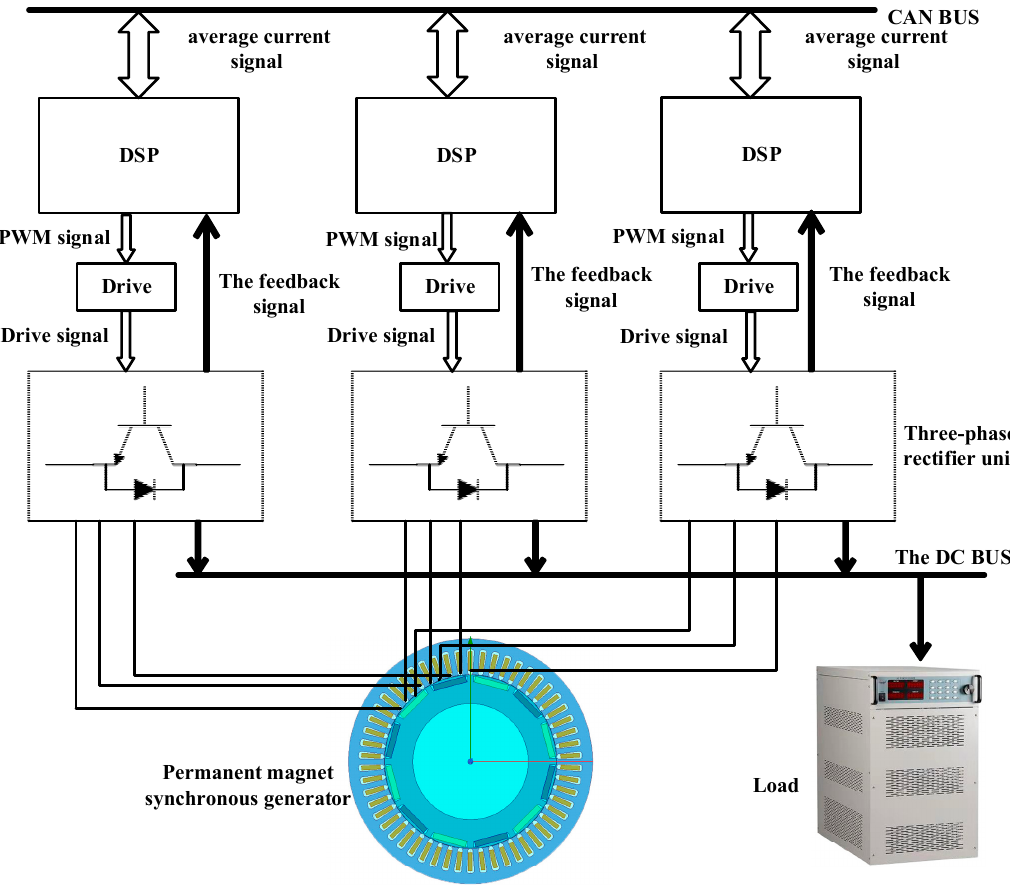
Figure 2. The block diagram of the synchronous DC power generation system with the multi-phase permanent